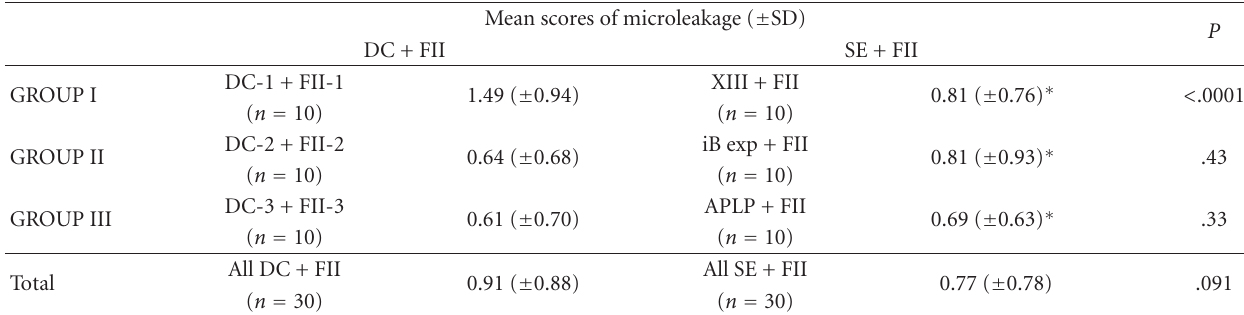
Table 3: Mean scores of microleakage for RMGIC restorations using a polyacrylic acid conditioning or three di ff erent self-etching adhesive